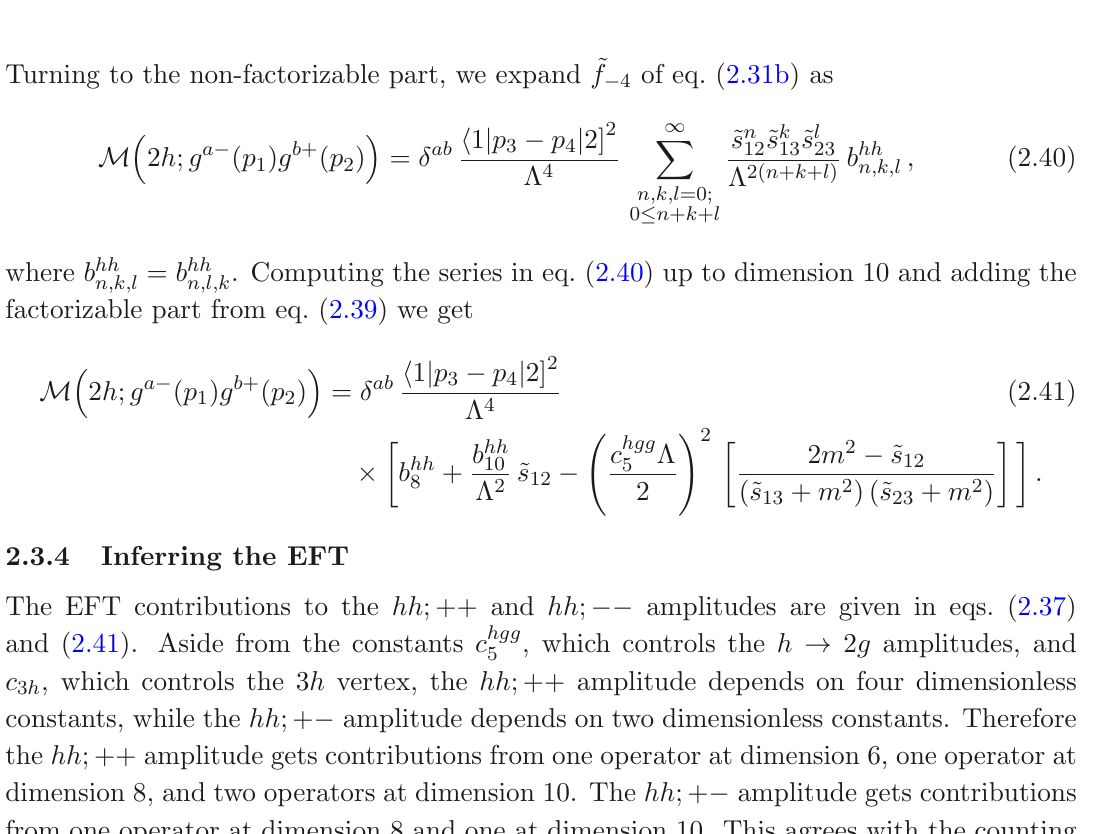
Table 2. Operators contributing to the hhgg amplitudes. The number of independent operators is shown in